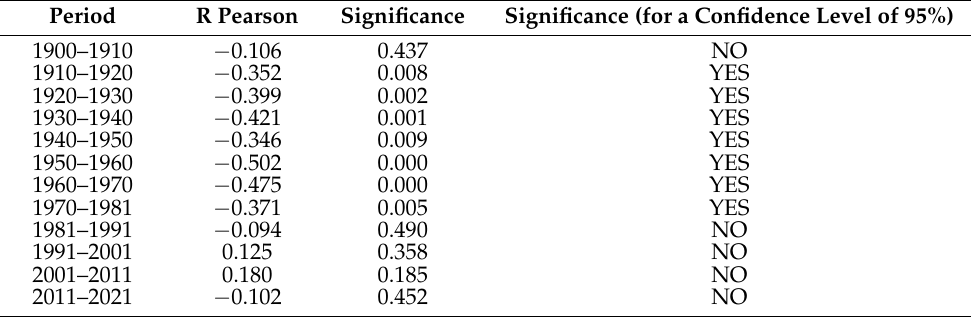
Table 2. Pearson test (population growth-distance to the centre variables). Period R